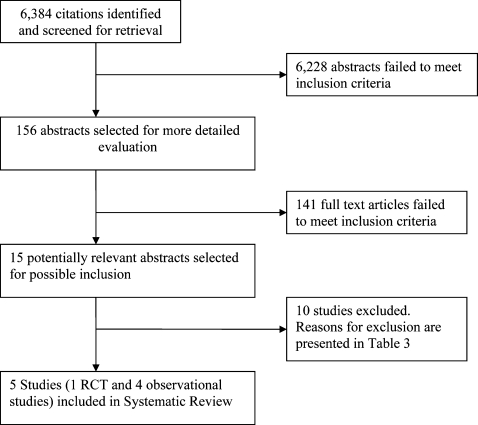
Flow diagram of study selection process in QUOROM format.